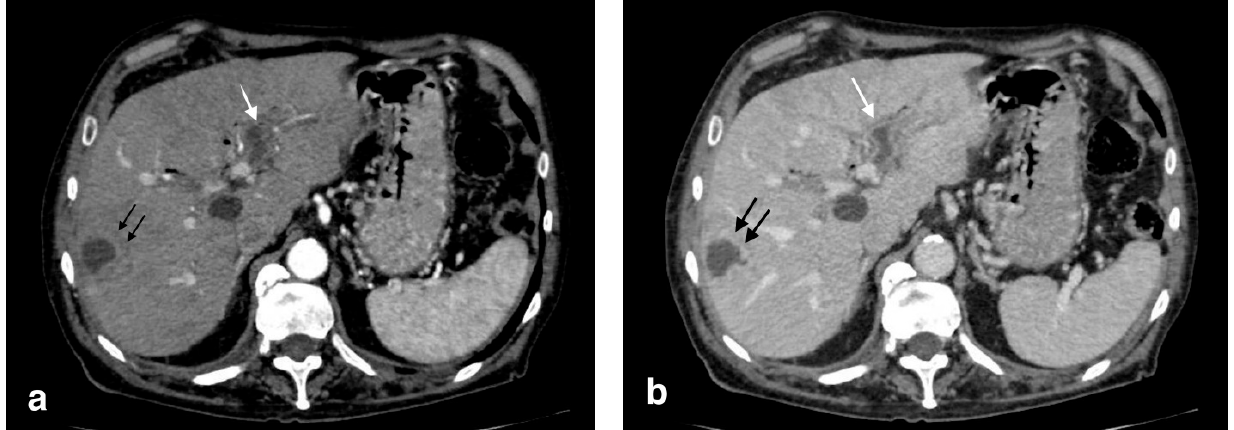
Figure 9. Liver abscess with pylephlebitis: ( a ) CT arterial phase; ( b ) CT portal phase. In the right lobe, V segment, a large hypodense collection with hypoattenuating halo due to intrahepatic abscess (black arrows, ( a , b )) with the presence of a hypodensity within the left portal vein lumen due to thrombosis and hyperdensity of portal walls indicative of pylephlebitis better defined in CT portal phase ( b ) (white arrow).